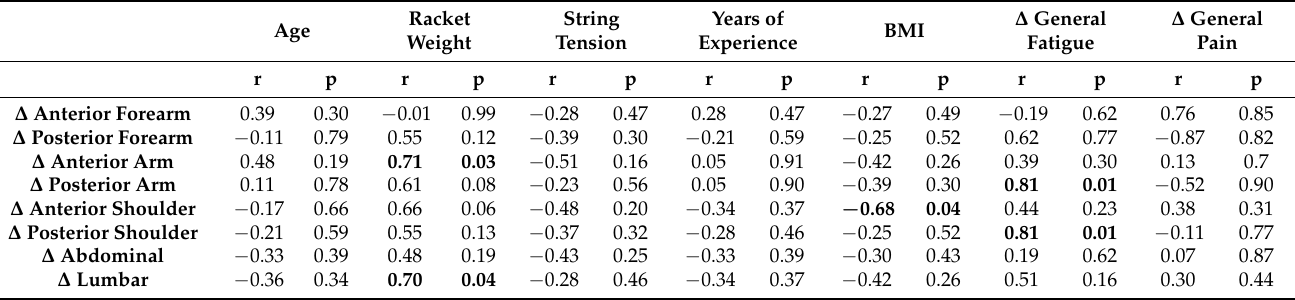
Table 2. Pearson’s correlation coefficient (r) and p value (p) between each ROI’s variation ( ∆ ) in thermal symmetry and age, racket weight, string tension, years of experience, body mass index (BMI) and variation in fatigue and pain. Significant correlations are highlighted in bold